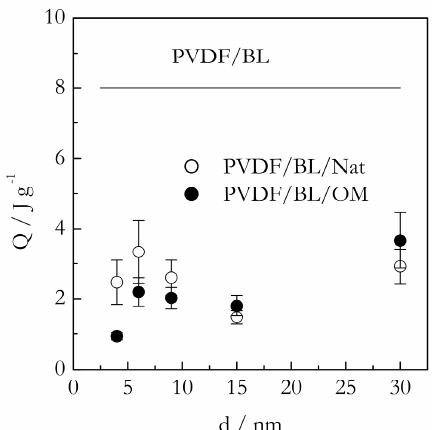
Figure 8. Heat of gelation of PVDF/BL in bulk (solid line) and confined systems PVDF/BL/Nat (open circles), PVDF/BL/OM (solid circles) dependence on the pore diameter size. The values of Q are given per gram of gel and represent the average of all cooling rates.